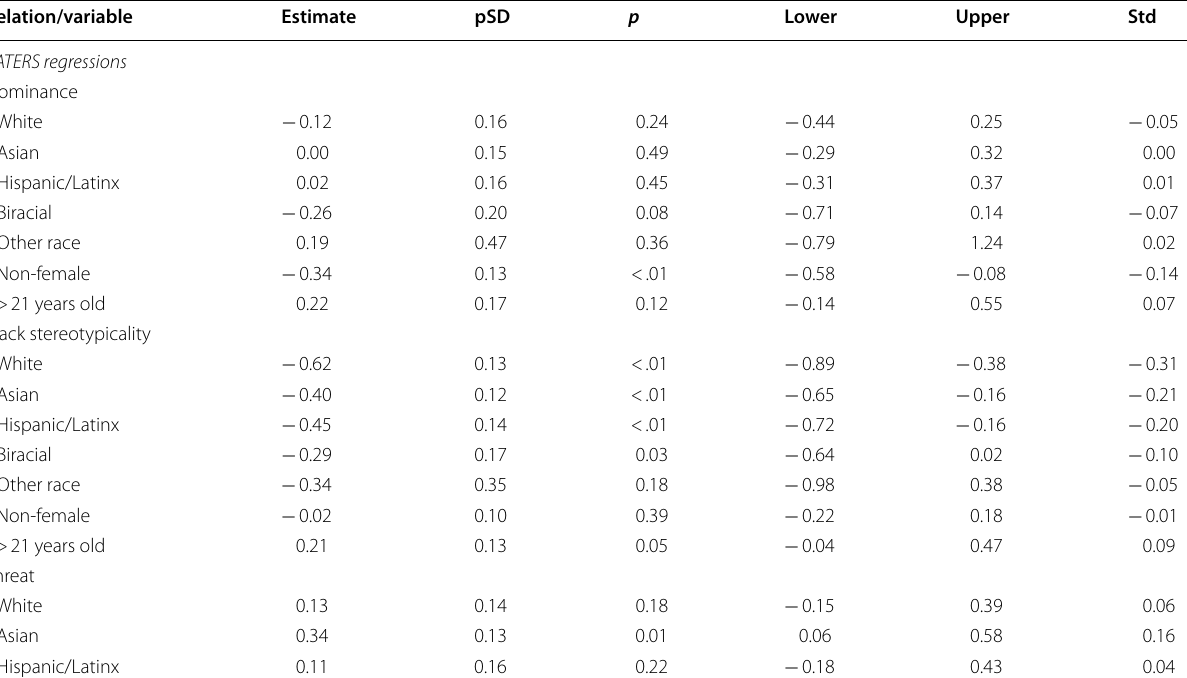
Table 3 Parameter estimates for level 2 (raters) of the two‑level